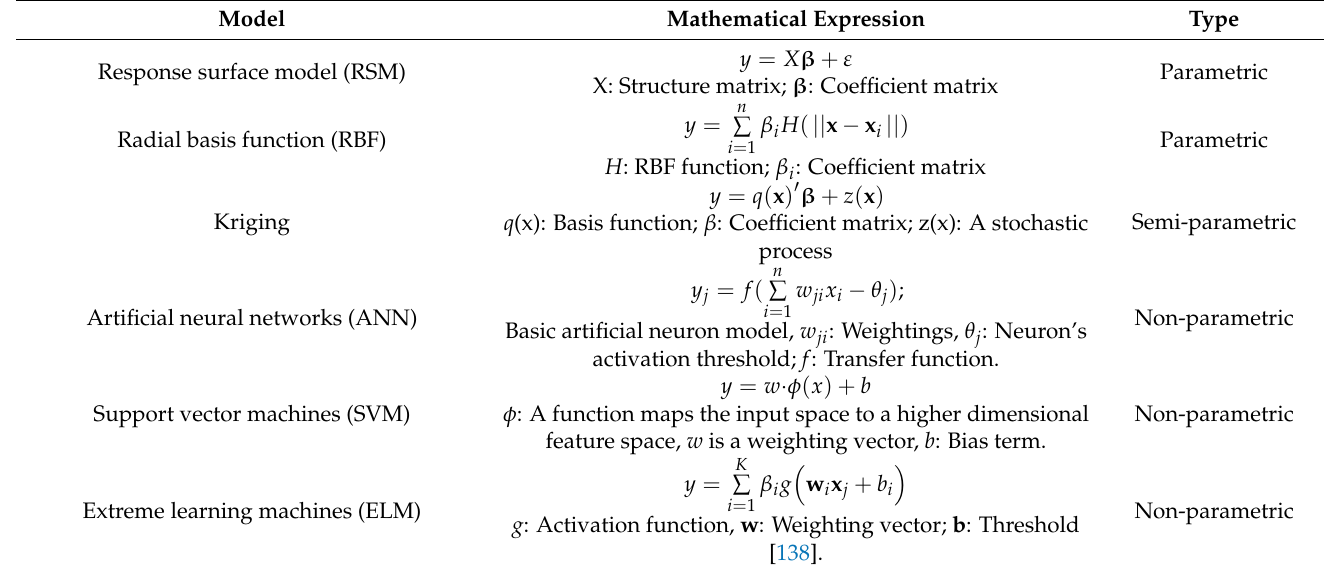
Table 1. Comparison of several surrogate